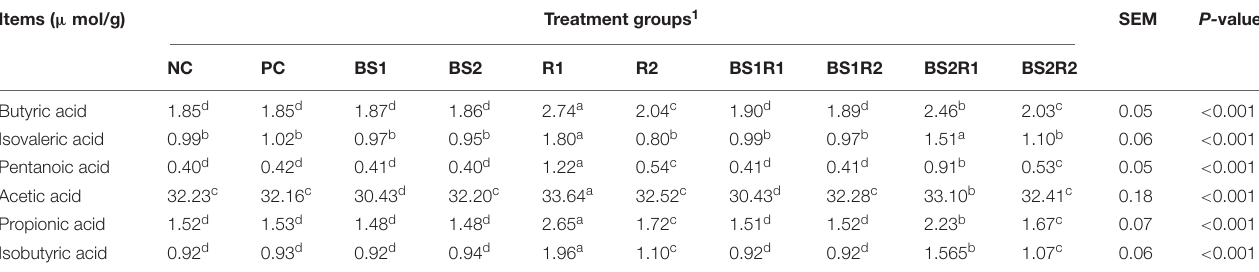
TABLE 4 | Effect of in ovo inclusion of Bacillus subtilis , raffinose, and their synbiotics on cecal volatile fatty acid concentrations at 21-day-old broilers. Items ( µ mol/g)